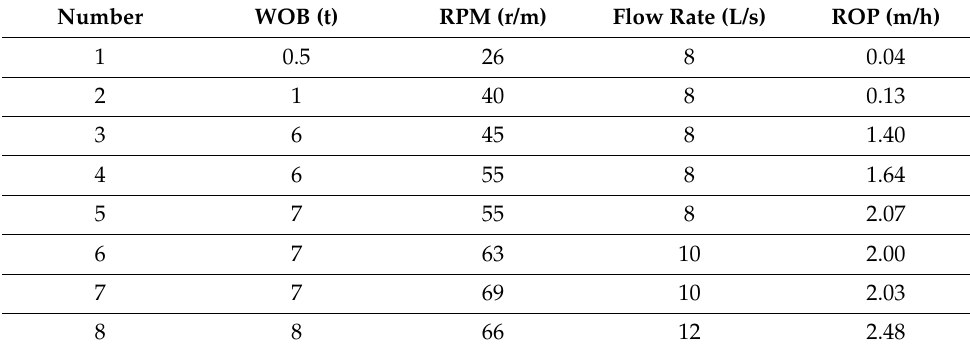
Table 3. Statistics on bit-drilling efficiency of roller core bit.